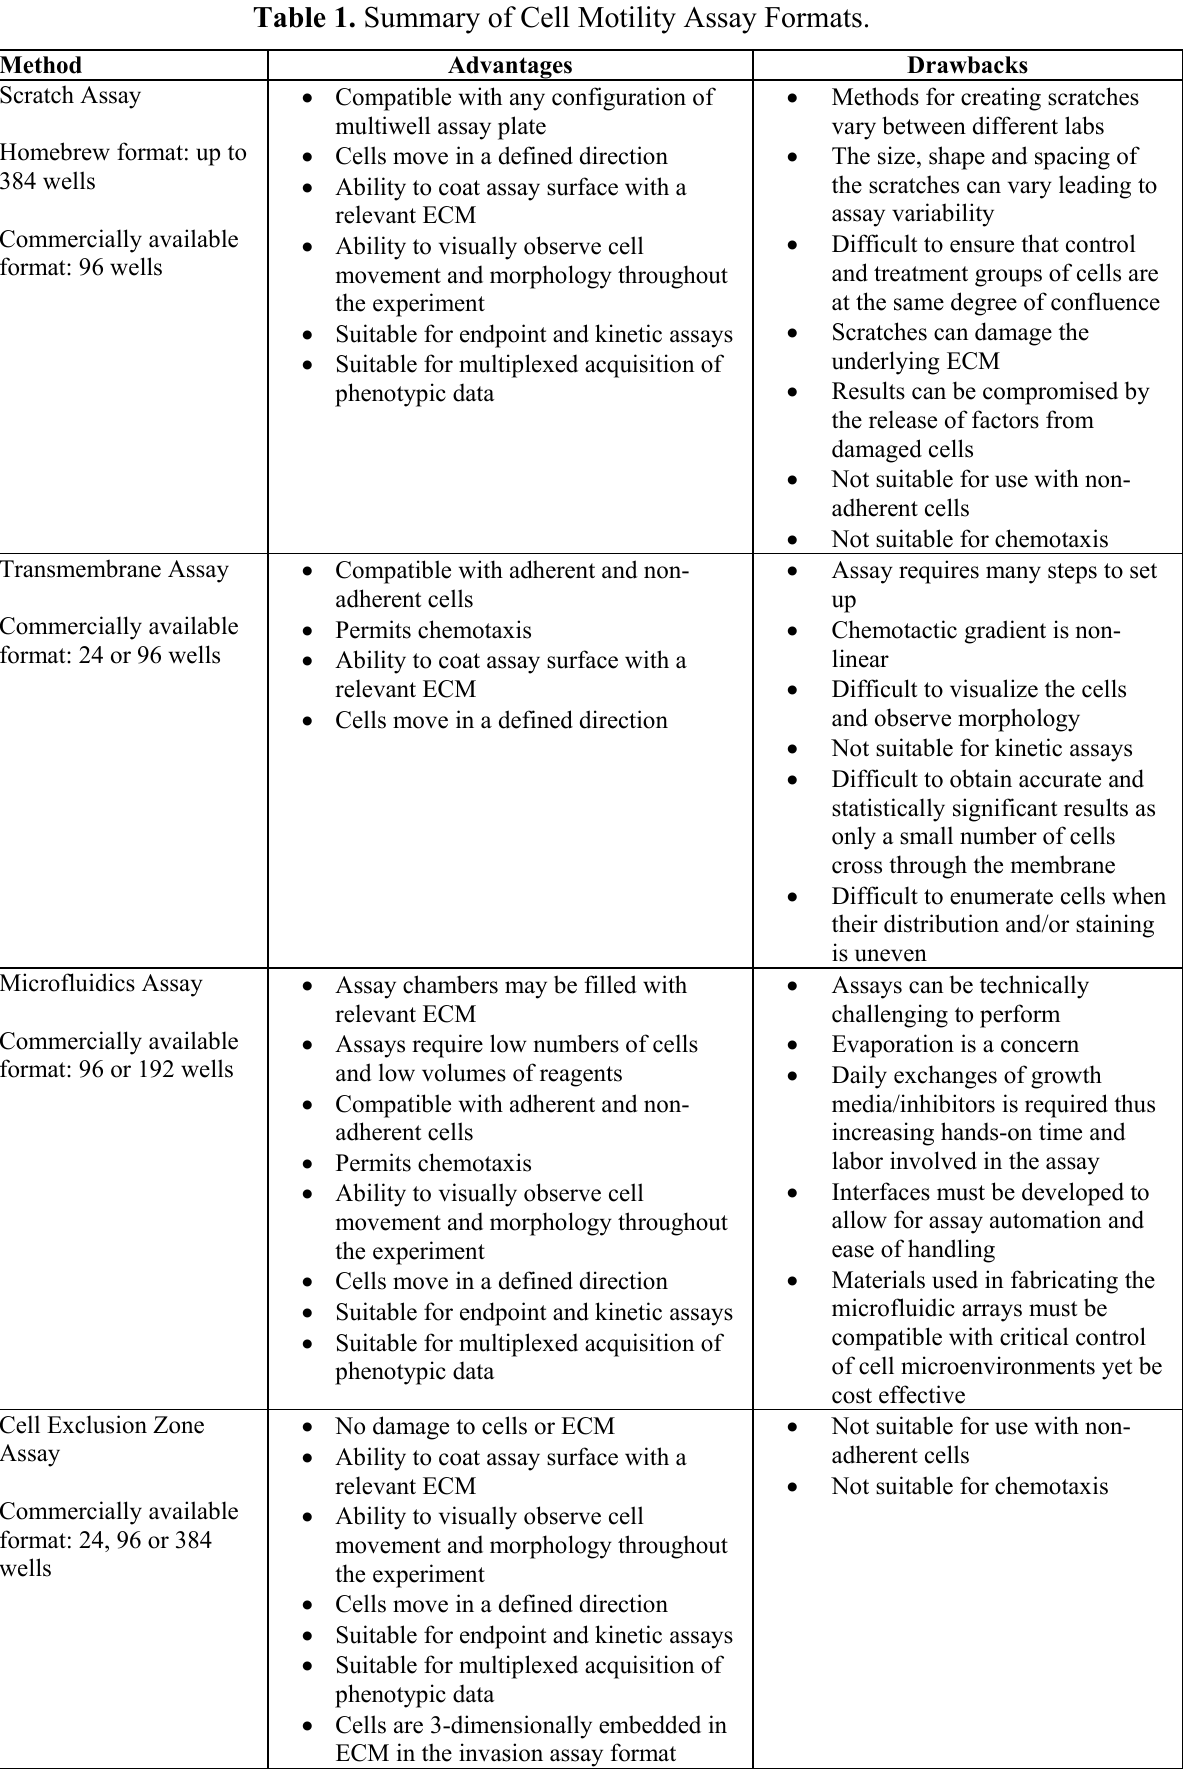
Table 1. Summary of Cell Motility Assay